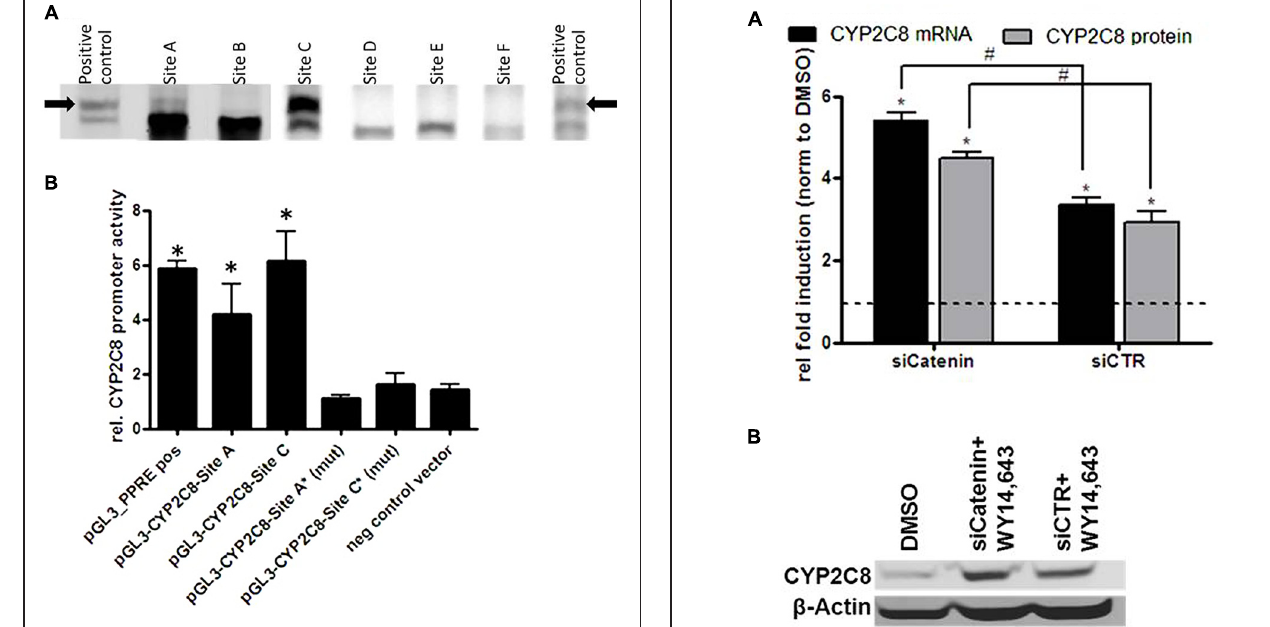
FIGURE 6 | Inhibitory role of β -catenin in the ligand-mediated induction of CYP2C8 by PPAR α . (A) mRNA (gray bars) and protein (black bars) expression levels of CYP2C8 were analyzed by quantitative real-time qRT-PCR and Western blotting, respectively, following treatment of HepaRG cells with 100 μ M of WY14,643 in the presence of β -catenin-targeting siRNA (siCatenin) or non-targeting control (siCTR). Shown are mean values of three independent experiments ± SD. ∗ , Statistically significant ( P < 0.05) compared with DMSO treatment set to 1; #, statistically significant ( P < 0.05) when siCatenin-treated cells compared to control siCTR-treated cells. (B) Representative western blot analysis of CYP2C8 protein expression following WY14,643-mediated activation of PPAR α in the absence (lane siCatenin + WY14,643) or presence (lane siCTR + WY14,643) of β -catenin. variants in UGT2B7 , CYP2C8 , and MRP2 may cause an